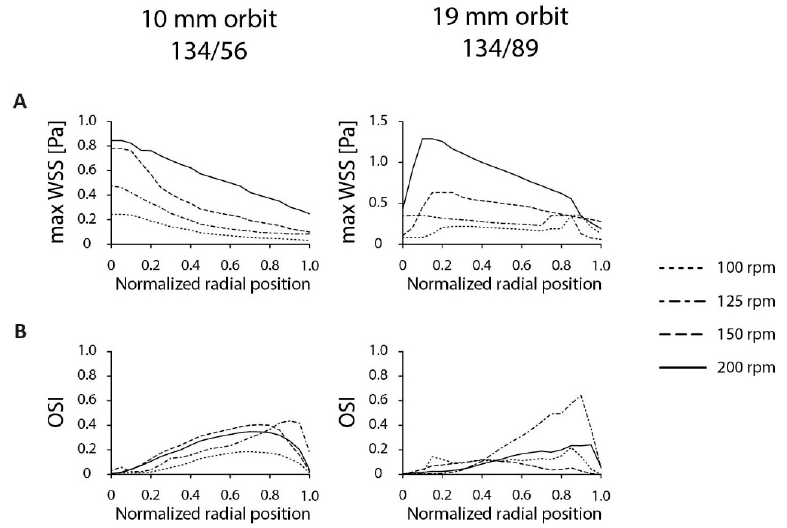
Figure 5. The influence of rotational speed on shear stress distribution. ( A ) Maximum shear stress level at each radial position for different orbital velocities in the 134/56 (10-mm orbit) and 134/89 (19-mm orbit) annular dish on an orbital shaker. For the calculations, a 3-mm fluid height was used. ( B ) OSI as a function of the radial position. Heat maps of the shear stress distributions can be found in Figure S3.